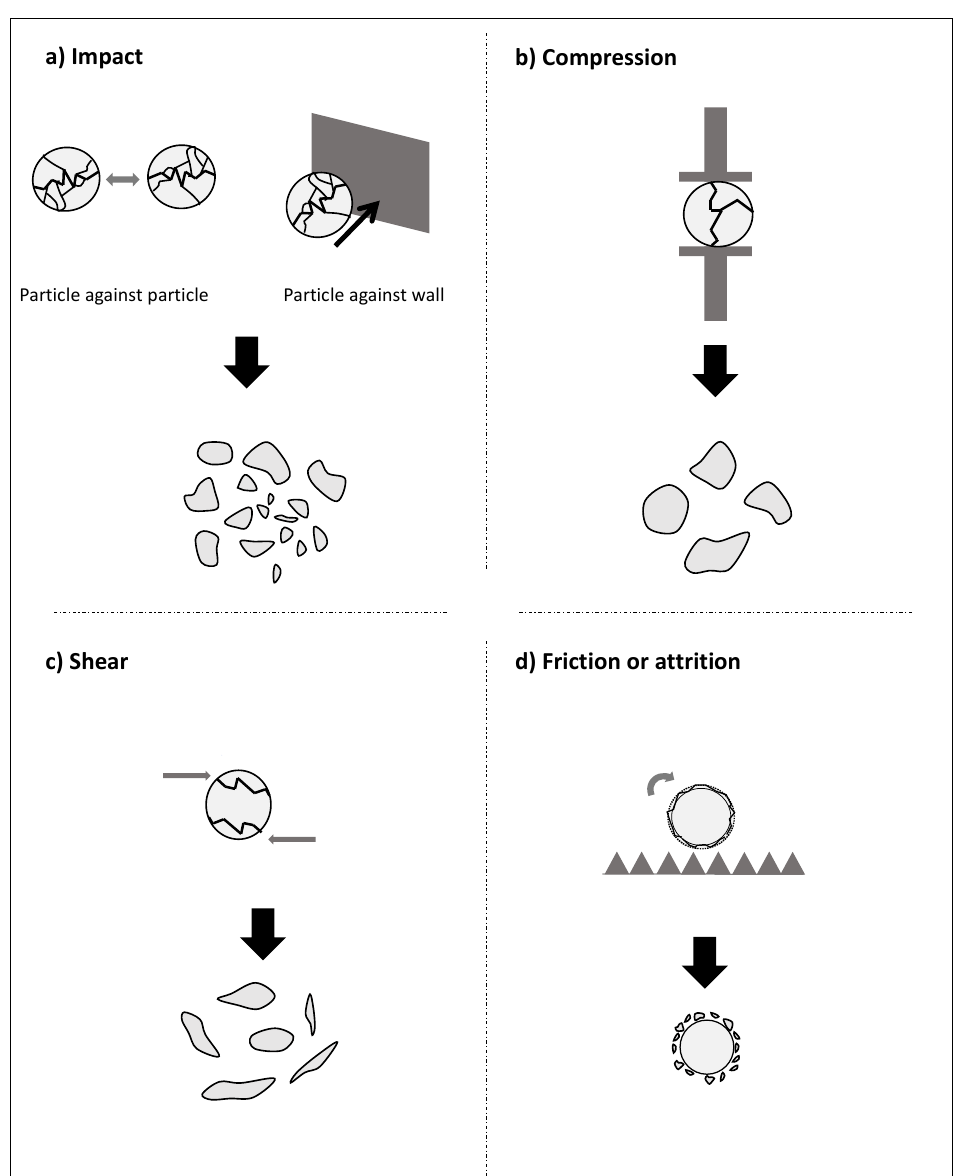
Figure 3. The main mechanical stresses in a grinder: ( a ) impact, ( b ) compression, ( c ) shear, and ( d ) friction and the particles that can be expected in case of comminution of an homogeneous materials according to Kaya et al.